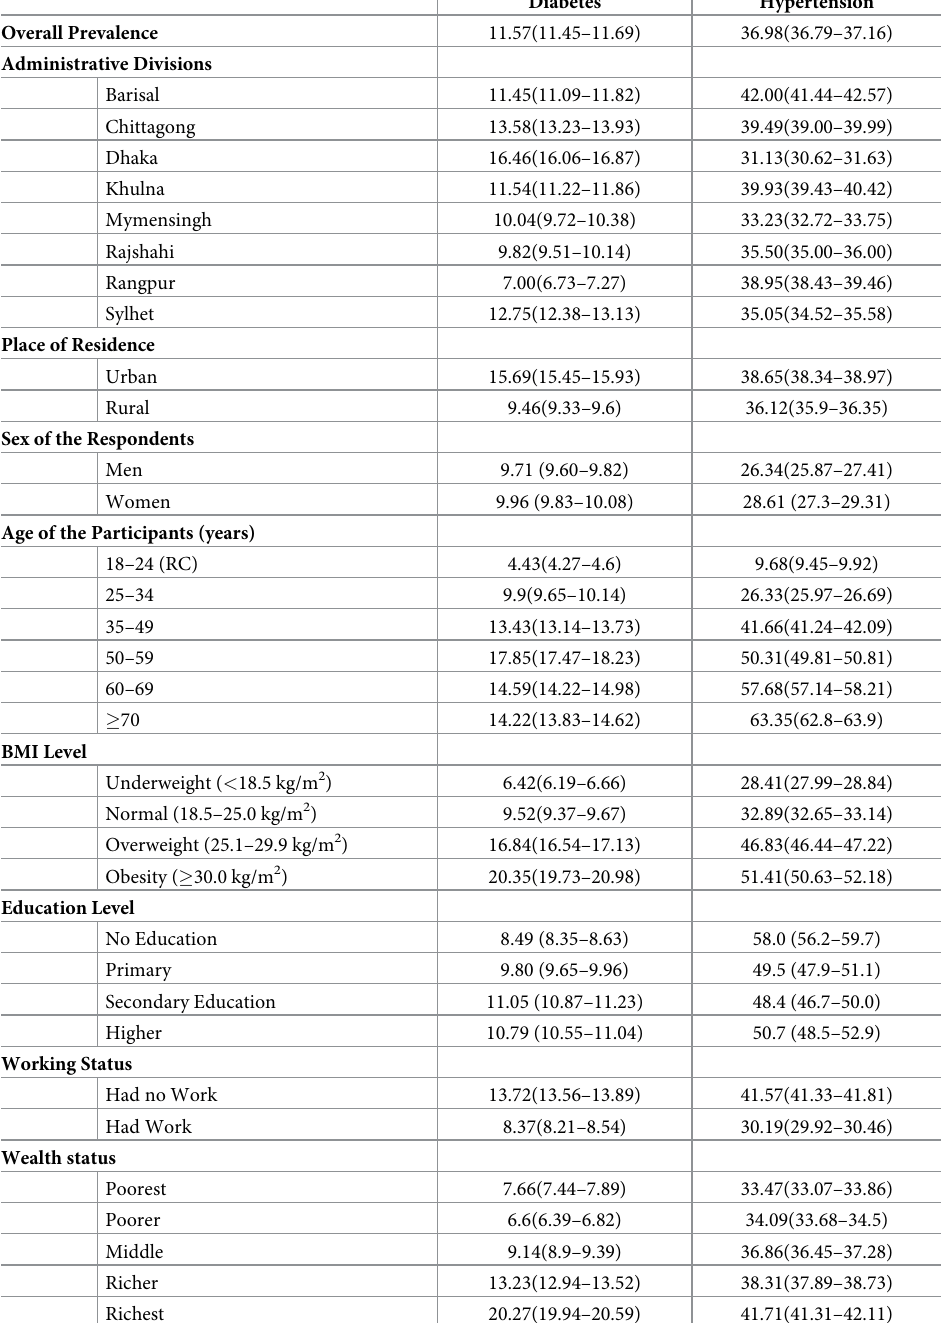
Table 2. Age-standardized prevalence of diabetes and hypertension with corresponding 95% confidence interval (95%